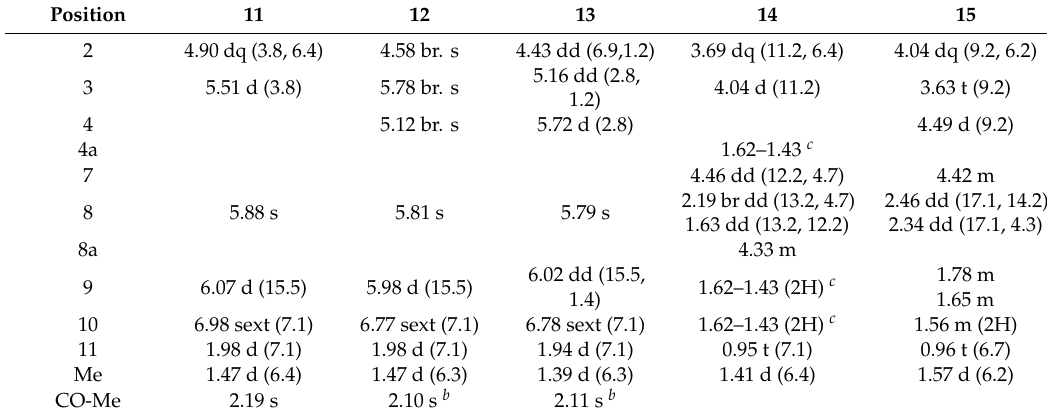
Table 2. 1 H-NMR data of acetyl derivatives of 3- epi -radicinin, radicinol and 3- epi radicinol ( 11 – 13 ) and of radicinin derivatives ( 14 and 15 ) a